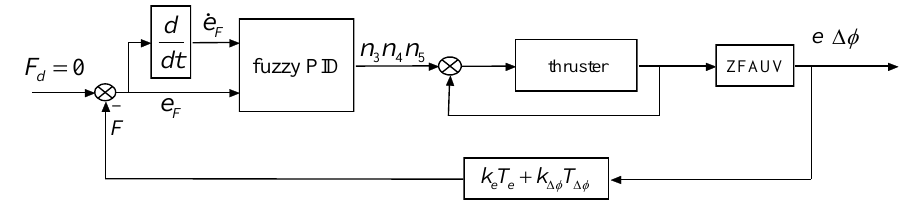
Figure 21. Path following controller.